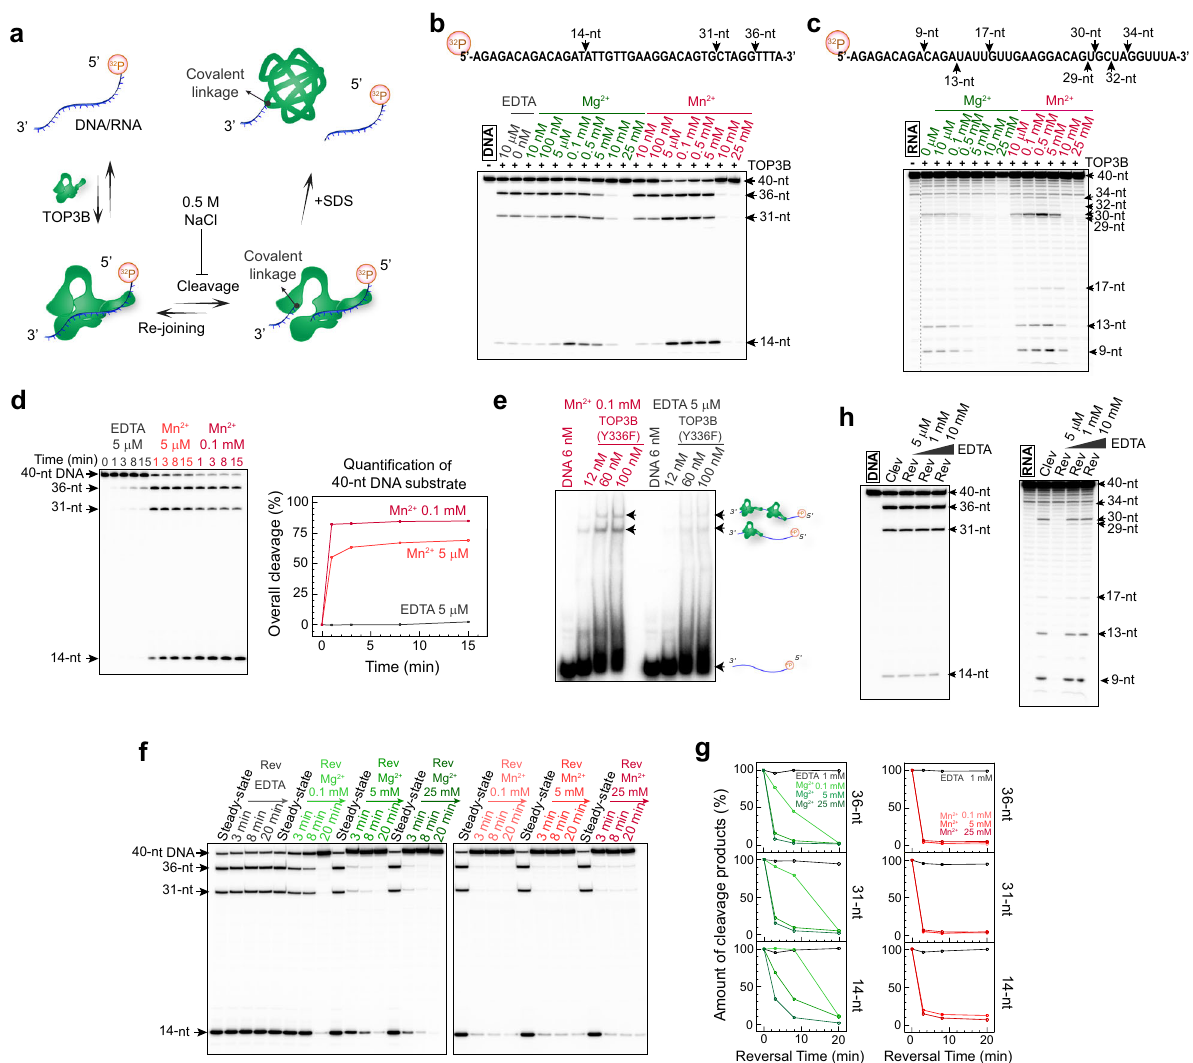
Fig.1 |TOP3B-mediatedDNAandRNAcleavageandrejoiningaredifferentially affected by Mg2+ and Mn2+. a Schematic diagram showing DNA/RNA substrate labelingandTOP3Bcleavageassay. b , c DNAandRNAcleavagebyTOP3Batvarious Mg 2+ and Mn 2+ concentrations. Arrows indicate majorDNA/RNAcleavage products and their corresponding cleavage sites in the substrate sequences. Gray dotted vertical line in c indicates combination of different lanes on the same gel with the same exposure condition. DNA cleavage sites were determined with sequence- speci fi cDNAoligosasmarkers.RNAcleavagesitesweremappedwithRNAalkaline ladder and RNase T1ladder (Suppl Fig. 2). d Time-course showing pre-steady-state DNA product formation in the absence of divalent cation (and with 5 μ M EDTA) or with 5 μ M or 0.1mM Mn 2+ . PlotofDNAcleavage productversus time wasobtained by analyzing the depletion of the 40-nt DNA substrate band. e EMSA assay with catalyticinactivemutantTOP3B-Y336FshowingitsDNAbindingintheabsenceand